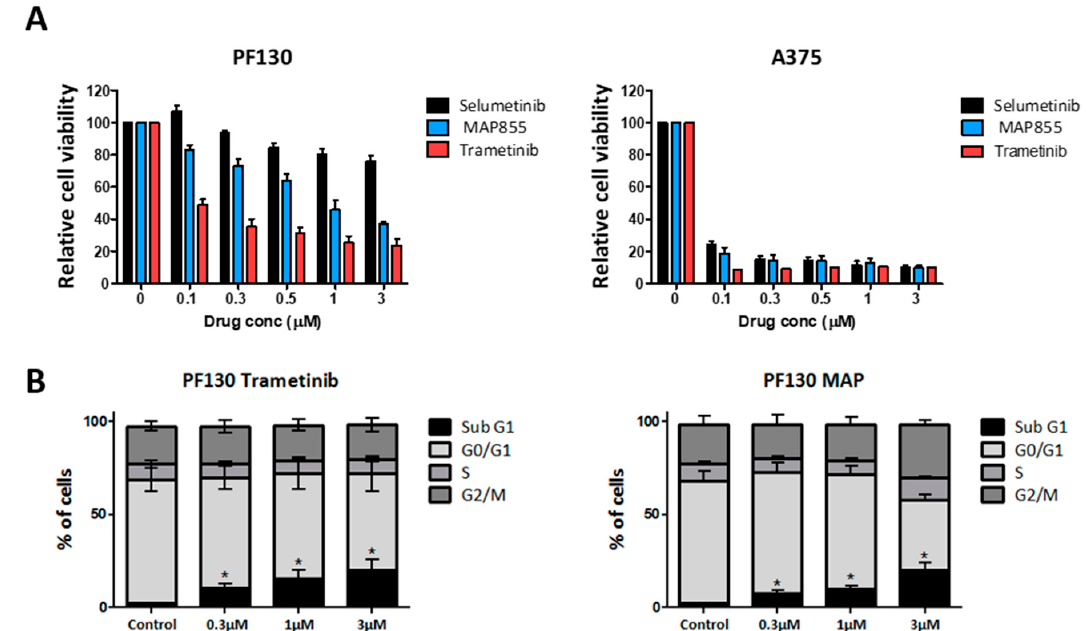
Figure 2. Sensitivity of PF130 cells to different MEK inhibitors. ( A ) Cell viability was measured after treatment with the MEK inhibitors selumetinib, trametinib or MAP855 for 72 hours. ( B ) Cell cycle analysis was performed after treatment with trametinib or MAP855 for 72 hours. Statistical comparison was calculated by one-way ANOVA with Dunn´s multiple comparison test ( p < 0.05). Bars represent means ± SE from two to three independent experiments.